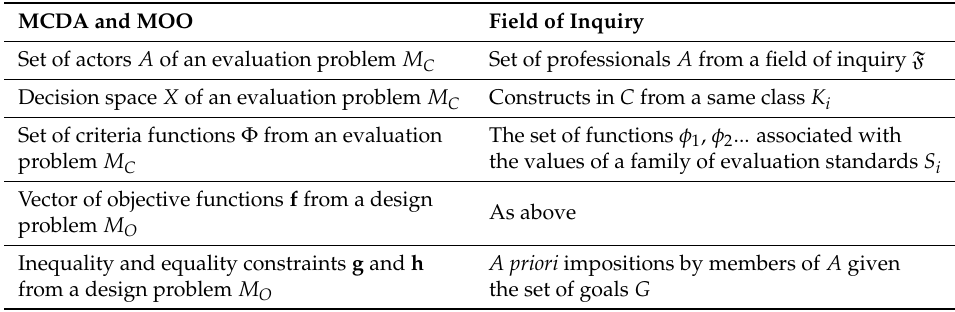
Table 2. Semantic